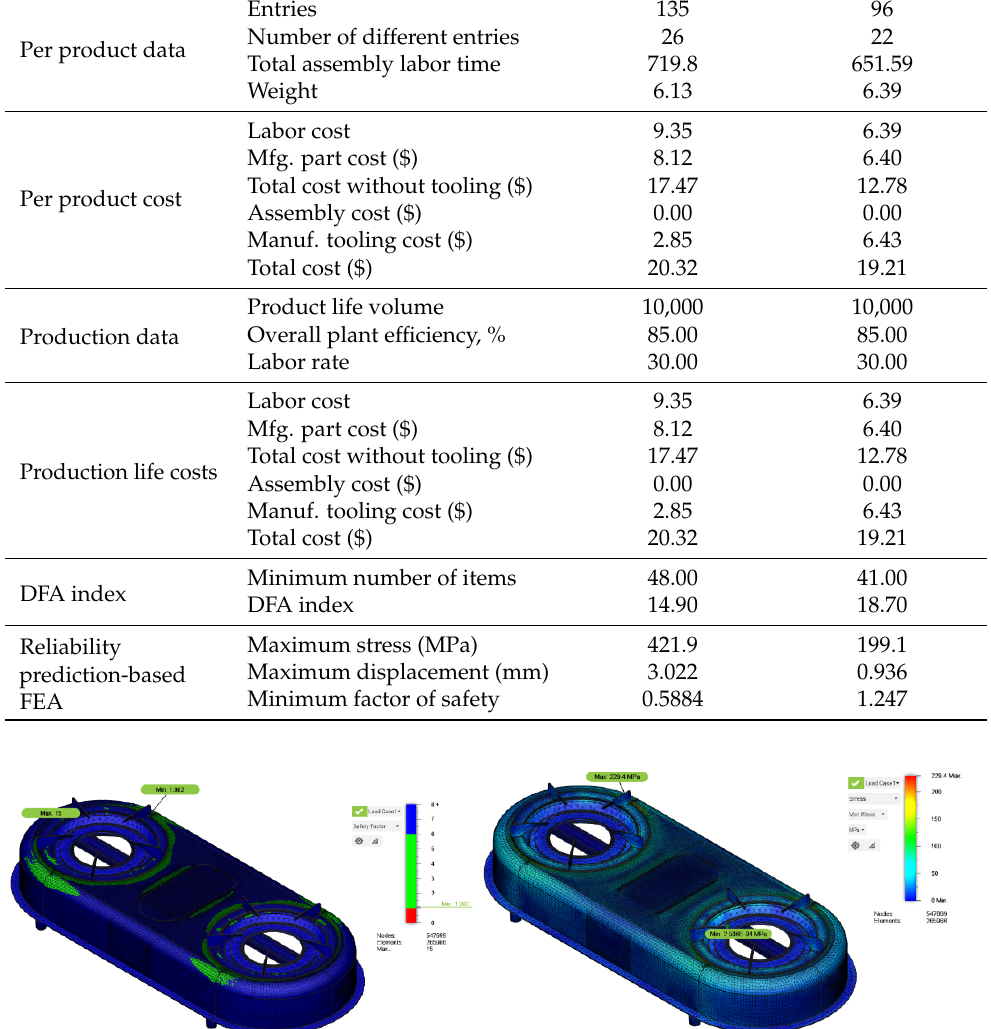
Figure 10. Minimum factor of safety and maximum stress of the redesigned stove.